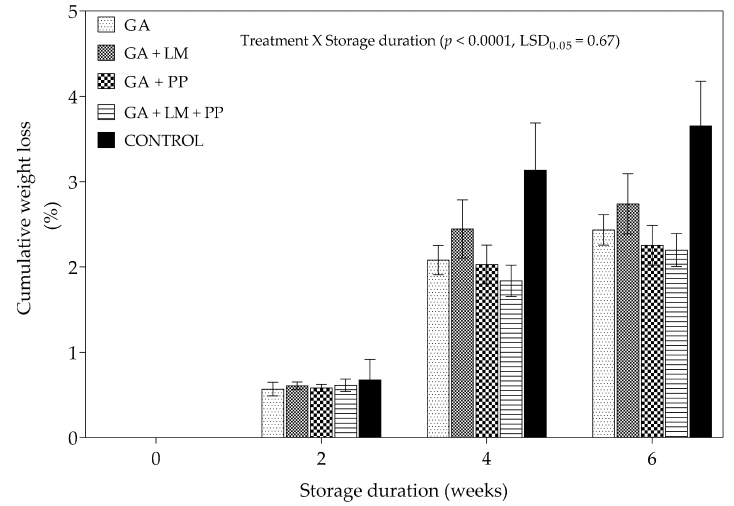
Figure 2. Cumulative weight loss (%) of ‘Wonderful’ pomegranate whole fruit coated with gum arabic (GA) coatings enriched with lemongrass oil (LM) (0.1% v/v ) and/or pomegranate peel extract (PP) (1% w/v ) and stored at 5 ± 1 ◦ C (95 ± 2% RH) for 6 weeks followed by 5 d at shelf-life conditions (20 ± 1 ◦ C and 60% RH). Vertical bars represent the standard error (SE) of mean values of 10 measurements (10 fruit per treatment). LSD 0.05 represents least significant difference ( p <